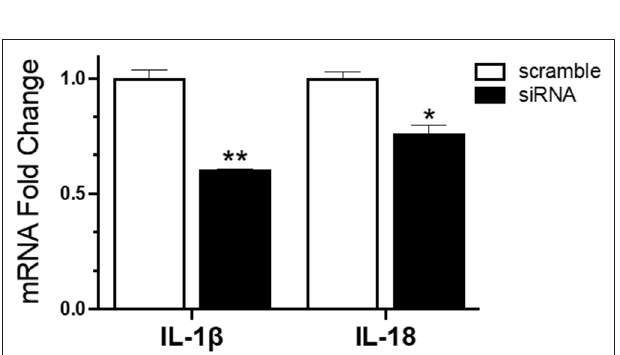
FIGURE 6 | Reduced mRNA expression of IL-1 β and IL-18 in IAV infected NLRC5 KD cells. MQ-NCSU cells were transfected with NLRC5 siRNA or non-specific control siRNA (scramble). The relative mRNA expression of IL-1 β and IL-18 was determined at 32 hpt by quantitative RT-PCR and normalized to the housekeeping gene HMBS. Data represents average of three biological replicates with error bars showing standard deviation. * p ≤ 0.05, ** p ≤ 0.01.